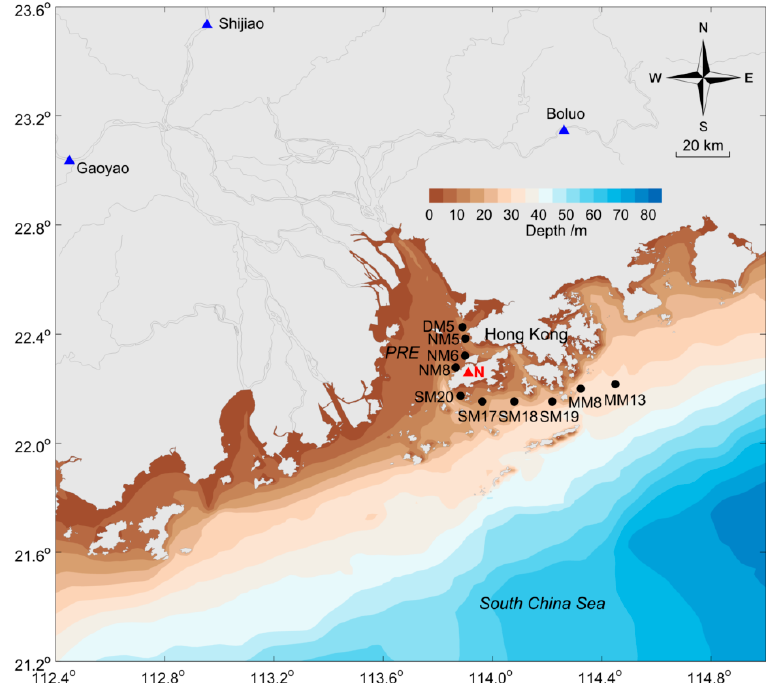
Figure 1. Sampling stations (dots in black) in the southeast of the Pearl River Estuary. PRE and N represent the Pearl River Estuary and Nei Lak Shan, respectively. Blue and red triangles represent